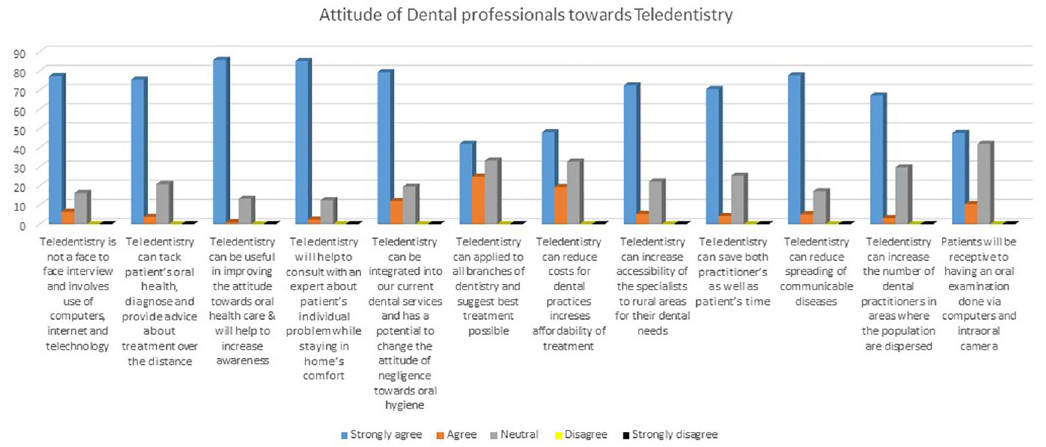
Figure 2. Attitude of dental professionals towards teledentistry.